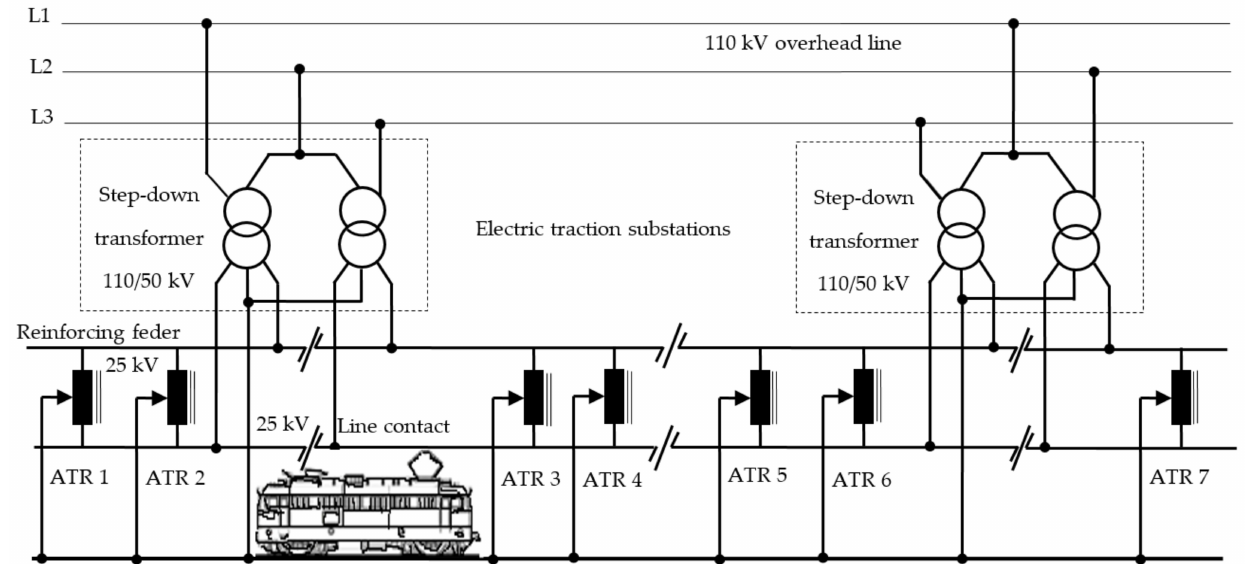
Figure 1. Schematic diagram of single-phase system with 25 kV, and 50 Hz with